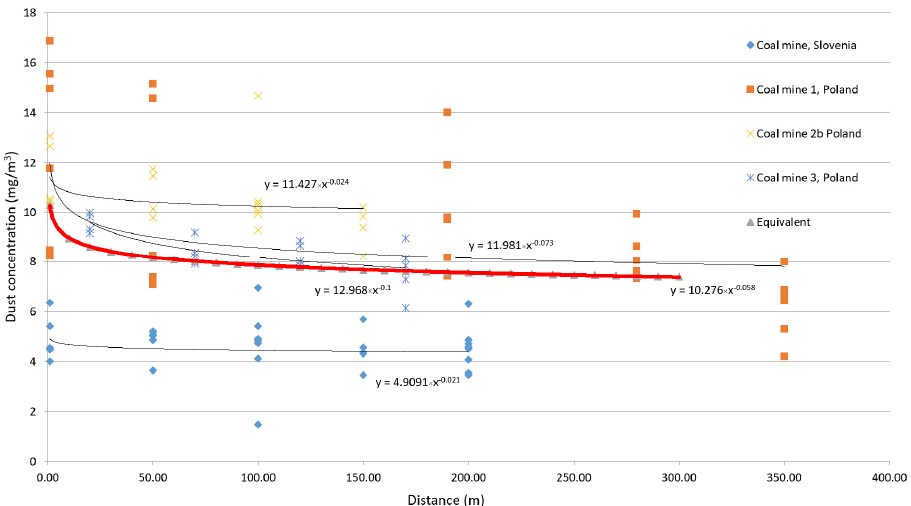
Figure 16. Equivalent characteristics of PM4 respirable dust concentration (measured by CIP-10R dust meter), depending on the distance from the dust source, determined on the basis of dust tests in four gates.